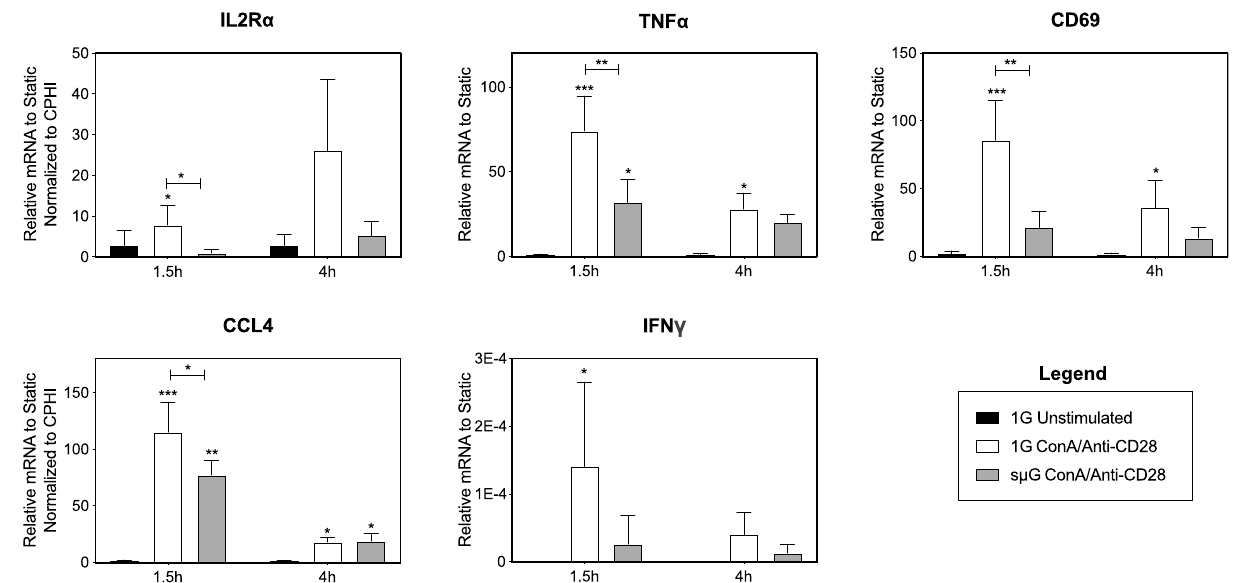
Figure 2. sµG alters immune cell transcriptional responses to ConA/anti-CD28 stimulation. Differential expression of indicated mRNA transcripts isolated from PBMCs exposed to sµG or 1G for 18 h then stimulated with ConA/anti-CD28 for 1.5 h or 4 h. Bar plots show median with standard deviation (n = 8). *indicates p < 0.05, **indicates p < 0.01, ***indicates p <